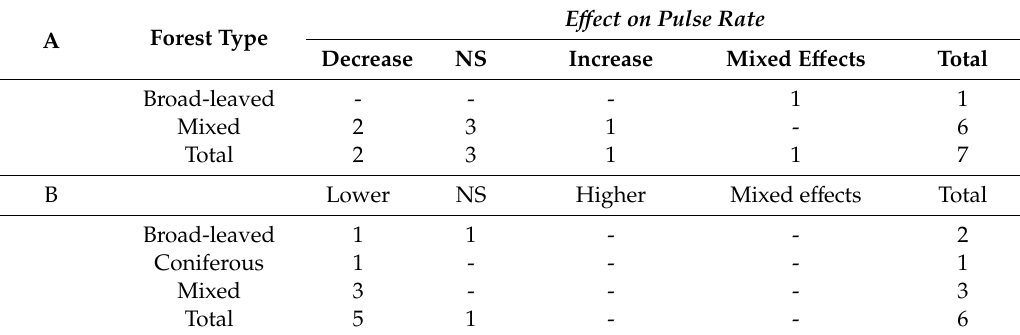
Table 4. E ff ects of forest type on pulse rate (PR) in the (A) before-after studies and the (B) control trials. NS, not significant.